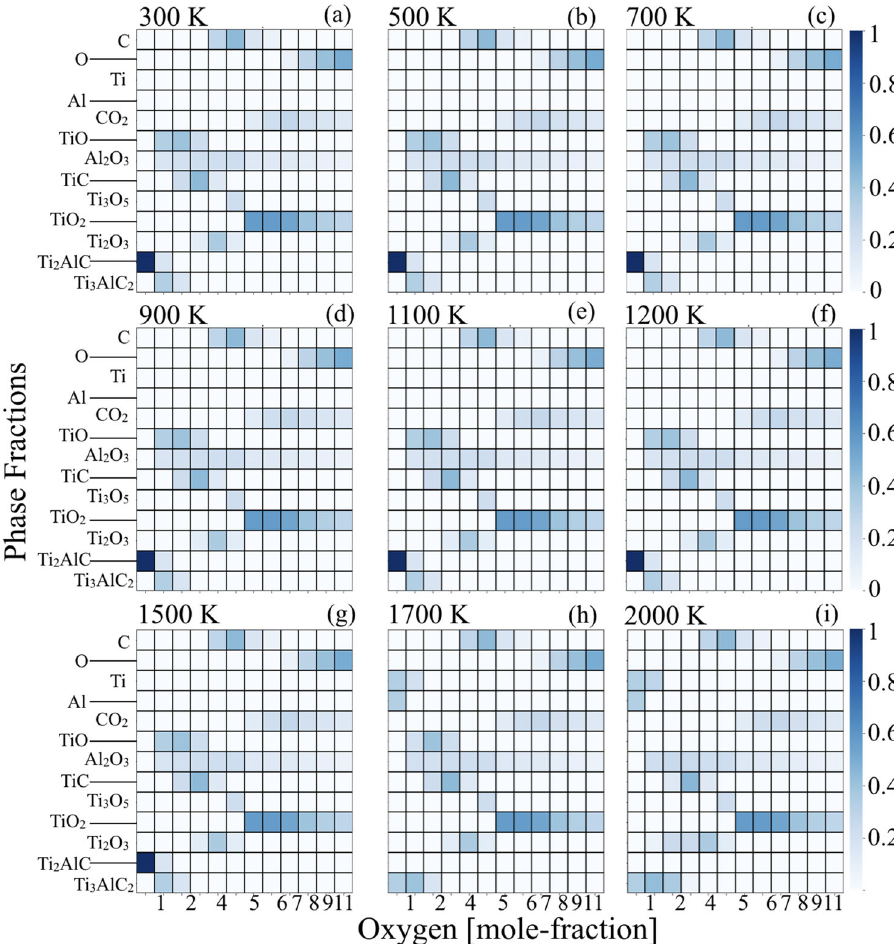
Fig. 5 Competing phases and phase-fraction of Ti 2 AlC + O 2 MAX phase. a – i Phase fractions of [Ti 2 AlC + O 2 ] reaction product at different temperature with changing molar percent oxygen (1 – 11 moles). The color gradient (shades of blue) shows molar phase fractions. Blank spot [white (0)] suggests no phases